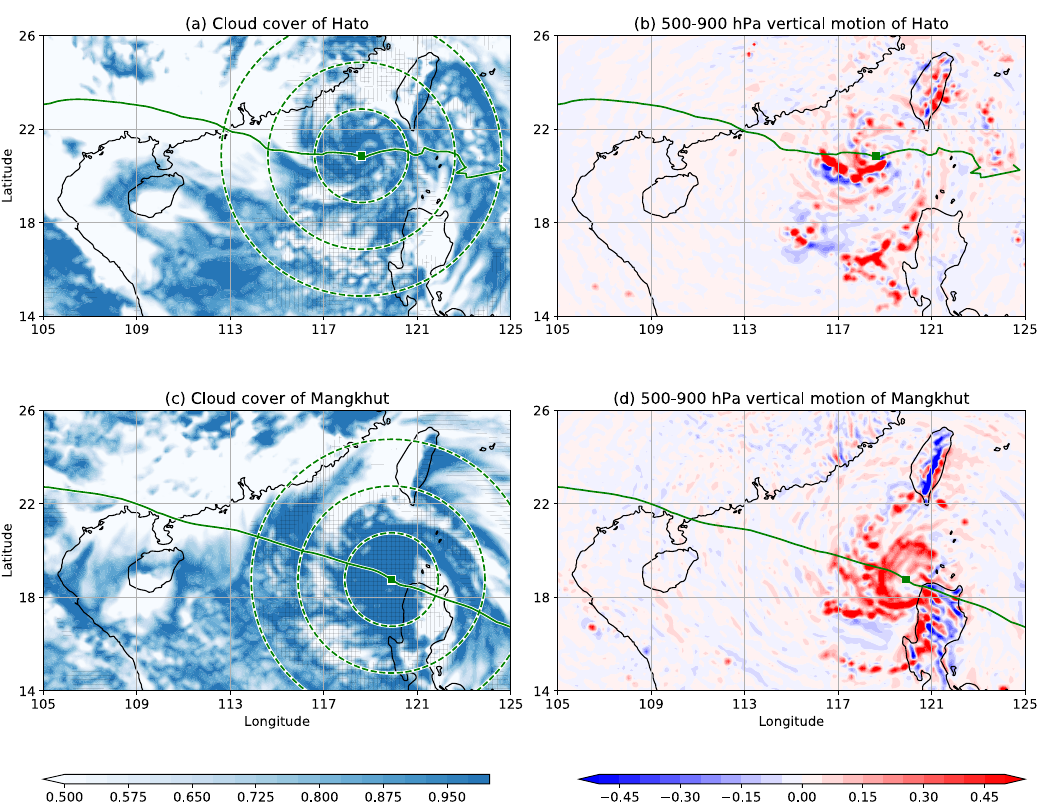
Fig. 5 Simulated cloud cover and vertical motion for Typhoons Hato and Mangkhut. Simulated a , c low-level cloud fractions and b , d 500 – 900hPa layer mean vertical motion in m s − 1 at 06 UTC on a , b 22 August 2017 for Typhoon Hato and b , c 15 September 2018 for Mangkhut. Mid- and high-level cloud fractions exceeding 80% are hatched with blue horizontal and red vertical lines respectively. Green lines are the corresponding tracks, with squares indicating the position of the TCs. 200, 400, and 600 km distances from the TCs are drawn in green dashed